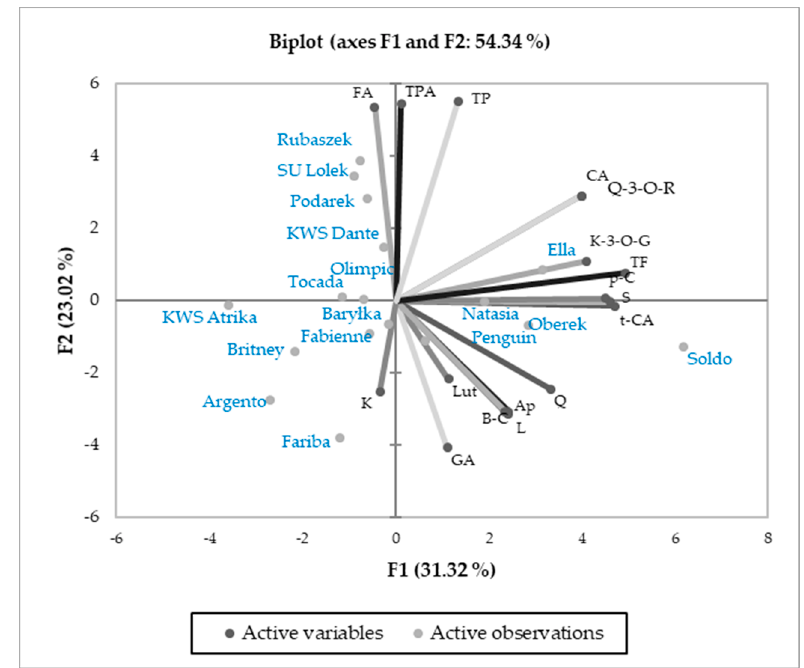
Figure 1. PCA biplot showing the relationships between the chemical composition of grains of the studied barley cultivars. Lutein (Lut), β -carotene (B-C), gallic acid (GA), ferulic acid (FA), caffeic acid (CA), t-cinnamic acid (t-CA), sinapic acid (S), p -coumaric acid (p-C), sum of phenolic acids (TPA), quercetin-3- O -glucoside (Q-3-O-R), kaempferol-3- O -glucoside (K-3-O-G), luteolin (L), quercetin (Q), apigenin (Ap), kaempferol (K), total flavonoids (TF), total polyphenols (TP).